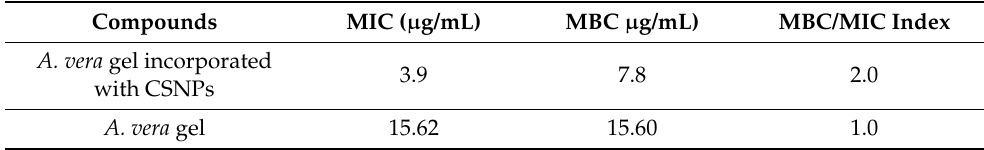
Table 4. Antioxidant activity of A. vera gel and A. vera gel incorporated with CSNPs. Concentra- tion (µg/mL)